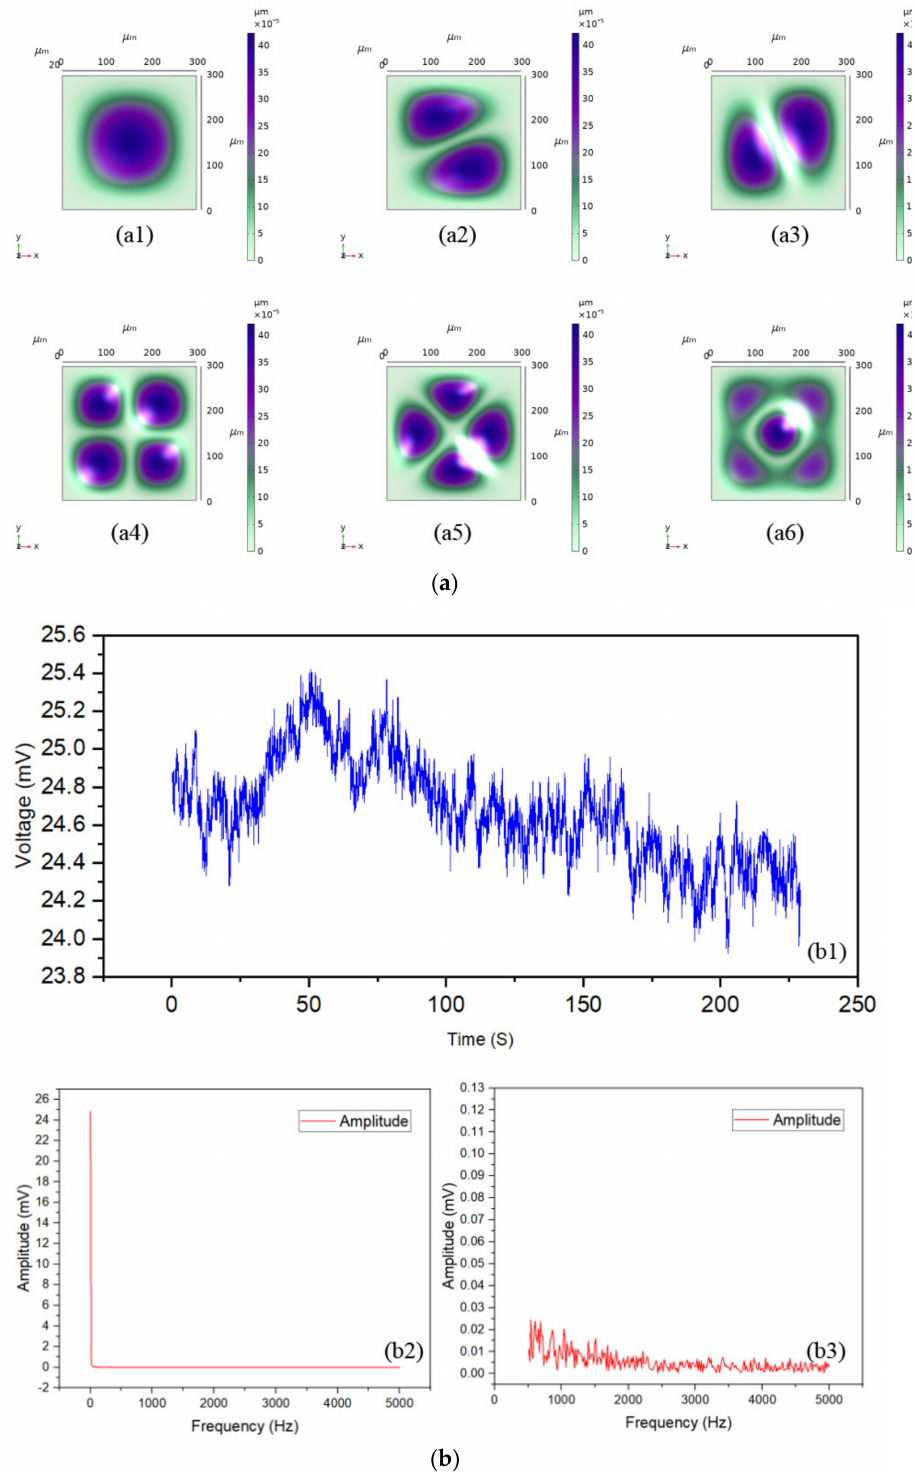
Figure 12. ( a ) Sensor eigenfrequency simulation. The diaphragm had six eigenfrequencies correspond- ing to six vibration modes: ( a1 ) 1,777,100 Hz; ( a2 ) 3,584,700 Hz; ( a3 ) 3,583,800 Hz; ( a4 ) 5,232,400 Hz; ( a5 ) 6,328,600 Hz; ( a6 ) 6,364,100 Hz. ( b1 ) Output during the vibration sweep; ( b2 ) Fourier-transform spectrogram based on b1; ( b3 ) frequency-domain characteristics of sensor output during 500–5000 Hz vibration, the max amplitude is 0.025